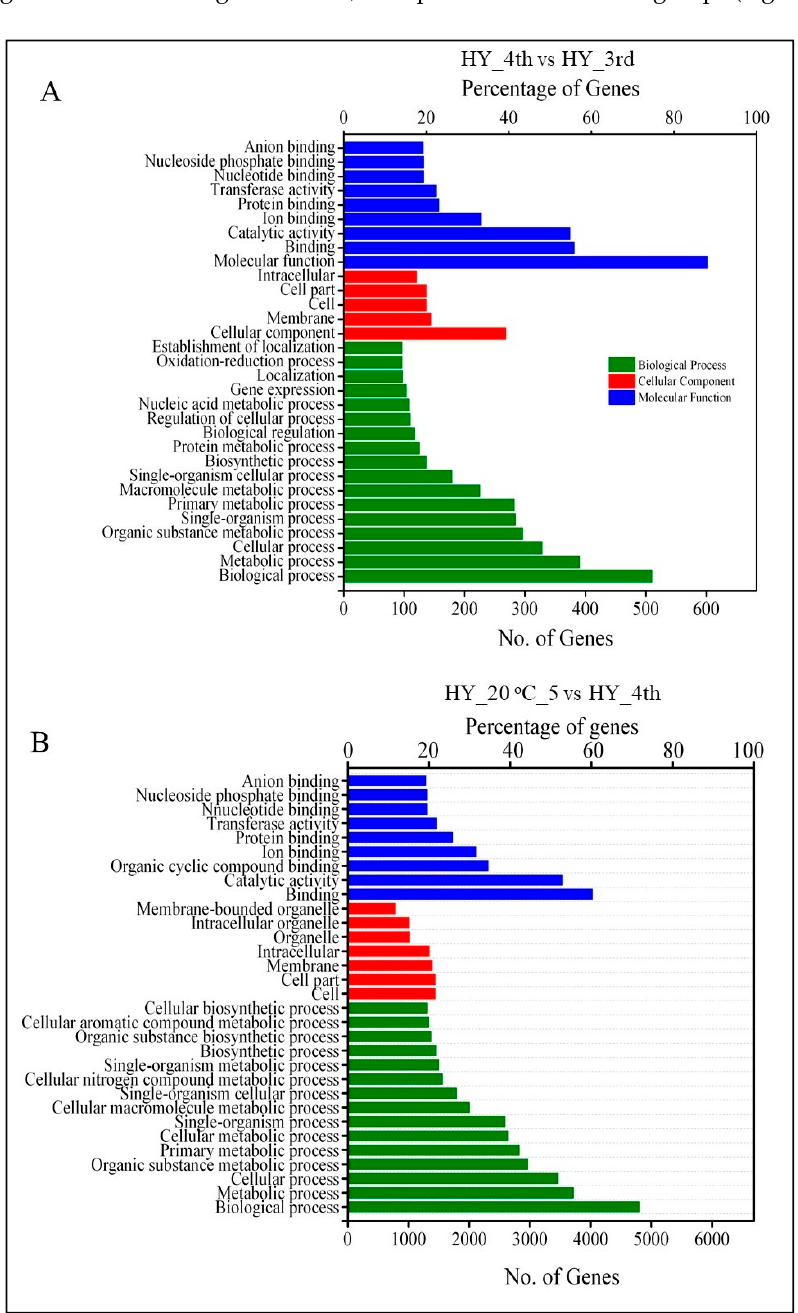
Figure 3. Classification of gene ontology (GO) terms concerning to differentially expressed genes in pre- ( A ) and post-ripening ( B ) apple fruit. The GO terms were classified into three categories, including molecular function, cellular component and biological process. Top 31 enriched GO terms were exhibited in each cluster.